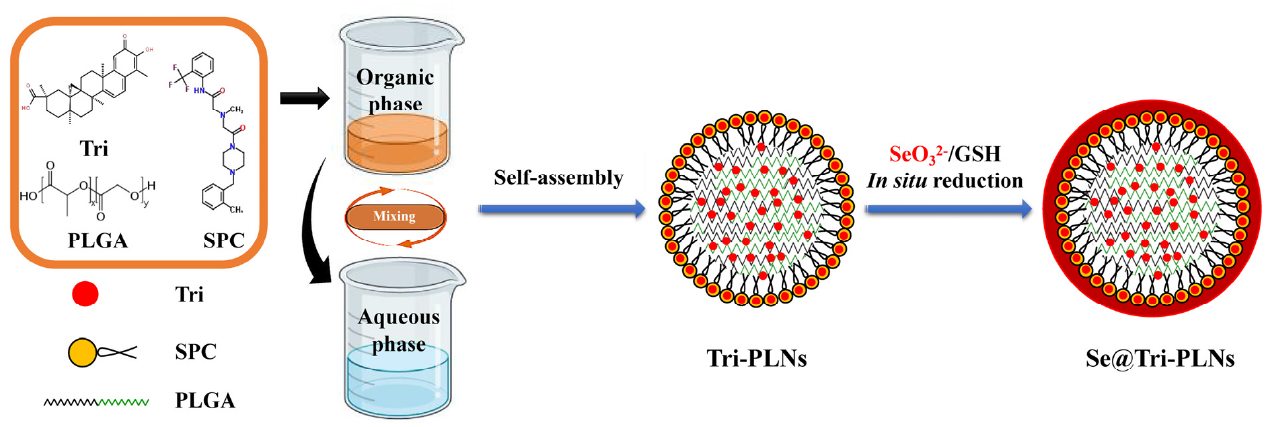
Figure 1. Schematic illustration of the structure and fabrication of Se@Tri ‐ PLNs.